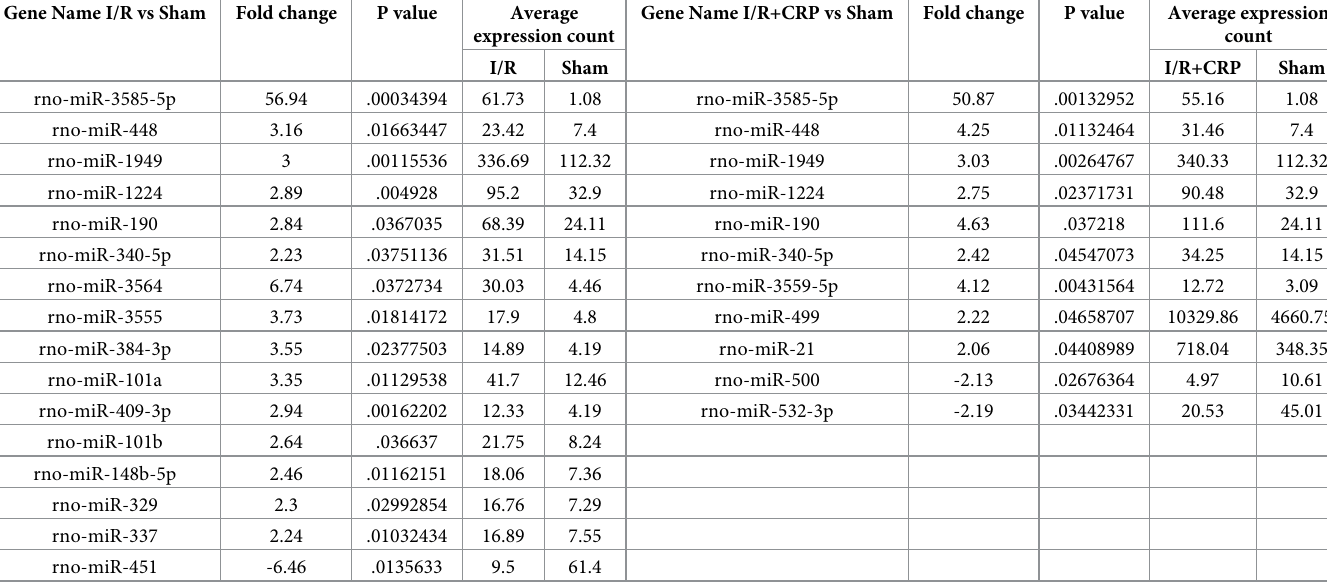
Table 2. Genes significantly changed in each group compared to the sham group in non-ischemic myocardium (blue area by evans blue and TTC staining). Gene Name I/R vs